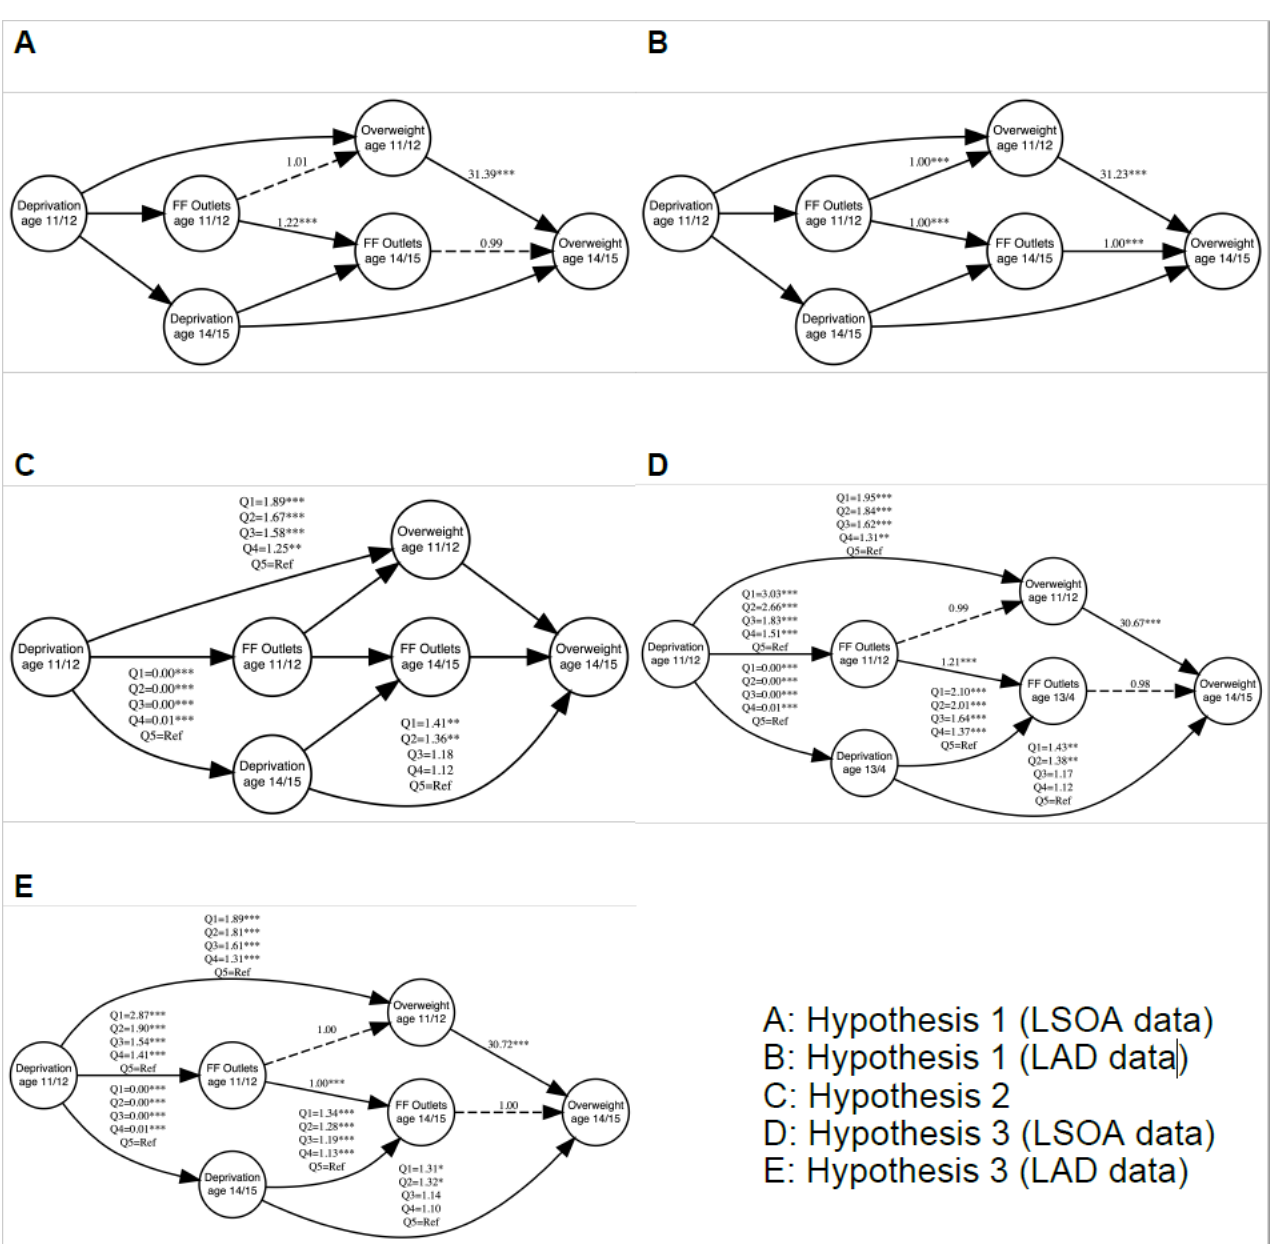
Figure 1. Five Structural Equation Models exploring the extent that the association between density of takeaways and overweight in children is confounded by deprivation. (Note: Odds Ratios are presented. Error terms are not presented to aid visual interpretation. The full outputs for models can be seen in the Supplementary material in Tables S1 to S4. Dotted lines represent insignificant associations, hard lines represent significant associations. * p < 0.05, ** p < 0.01, *** p < 0.001. LSOA = Lower Super Output Area. LAD = Local Authority District).